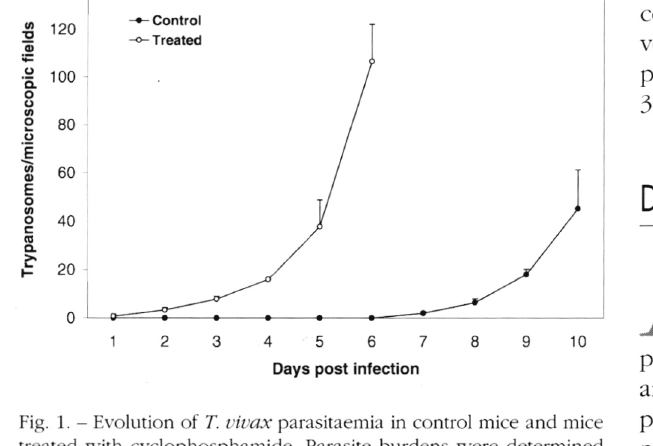
Fig. 1. - Evolution of T. vivax parasitaemia in control mice and mice treated with cyclophosphamide. Parasite burdens were determined from mouse blood and are represented as mean + SD for five mice per group. Statistically significant differences (p < 0.001) between mouse groups were observed from day 2 post infection onward. These results are representative for three individual experiments per­ formed.